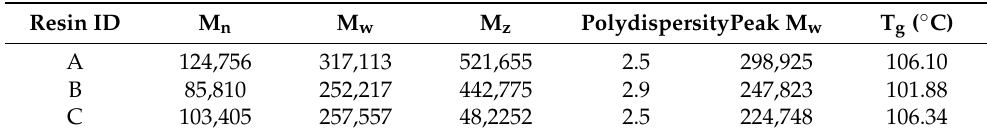
Table 1. Molecular weight distribution (MWD) parameters and the glass transition temperatures (Tg) for all the PS